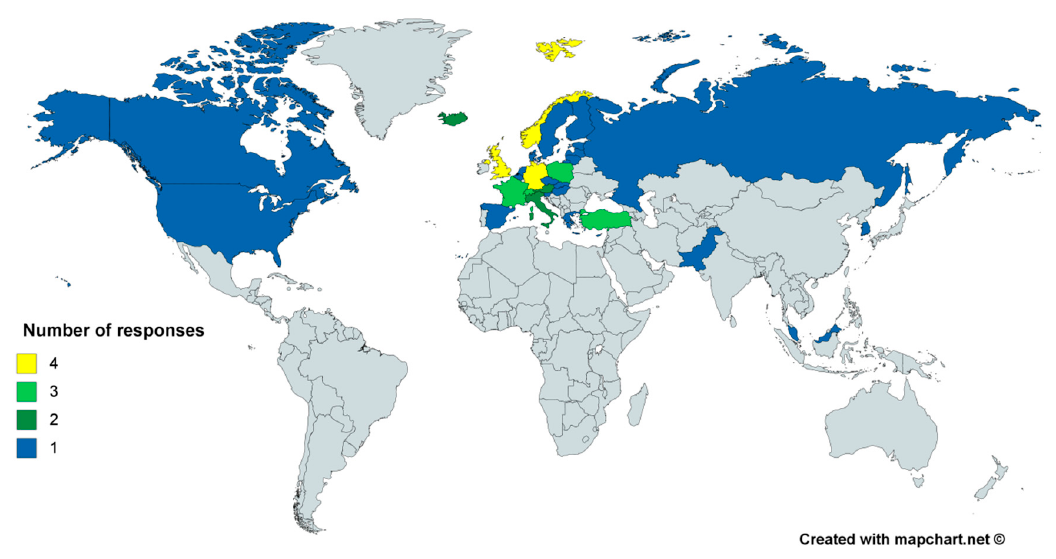
Figure 1. Geographical distribution of number of responses in the survey.